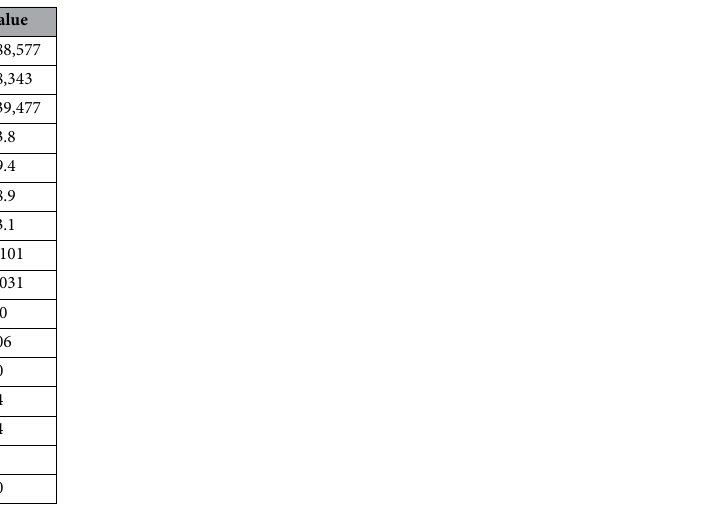
Table 1. Assembly and gene annotation statistics of the mitochondrial genome of Erysiphe necator